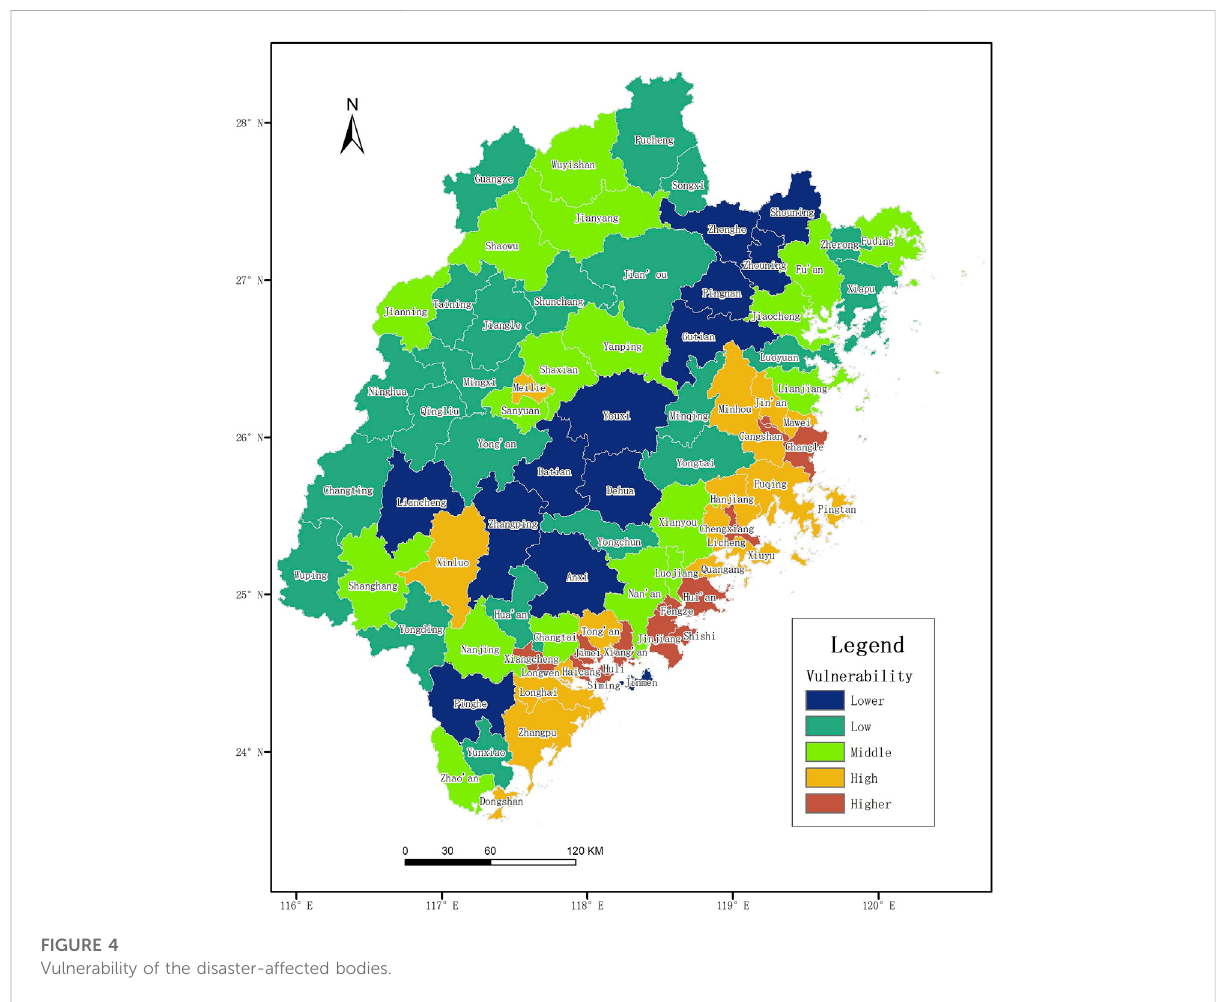
FIGURE 4 Vulnerability of the disaster-affected bodies.